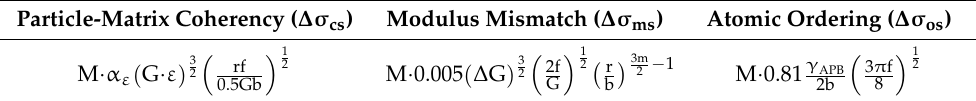
Table 2. Equations modelling precipitation hardening of shearing mechanism